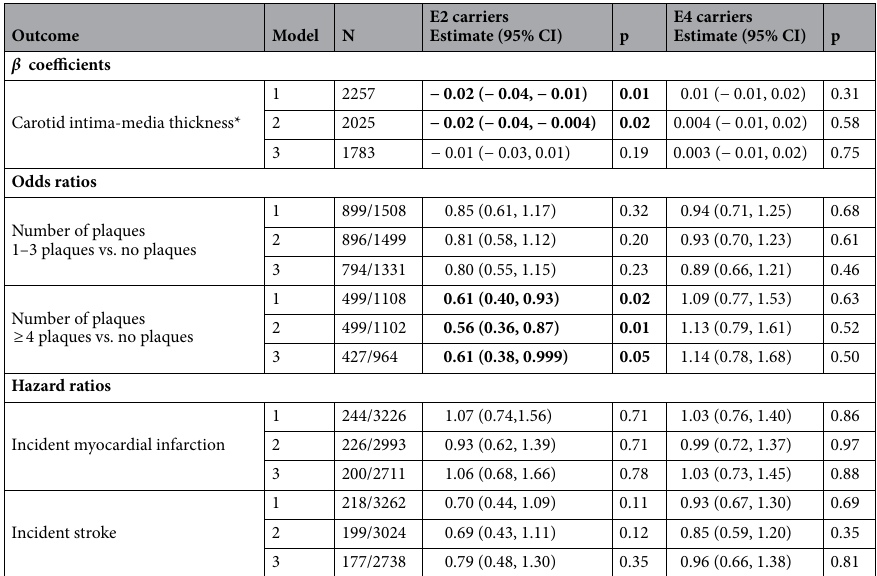
Table 2. Association of APOE allele status (E2 and E4 carriers versus E3 homozygotes) with carotid intima thickness, carotid plaques, incident myocardial infarction and stroke. Significant associations are shown in bold font. Model 1 adjusted for age and sex; Model 2 adjusted for model 1 + baseline values of body mass index, smoking status, alcohol consumption, sedentary lifestyle, hypertension and type 2 diabetes; Model 3: model 2 + low-density lipoprotein and high-density lipoprotein cholesterol. *Carotid intima-media thickness and plaques were assessed only at baseline.